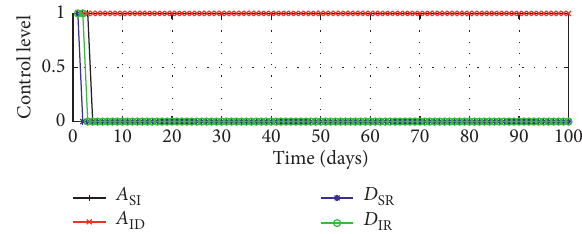
Figure 5: Optimal dynamic control without charging factors. The difference (Figure 4) is the change of the five control variables in the absence of UAVs within 100 days.